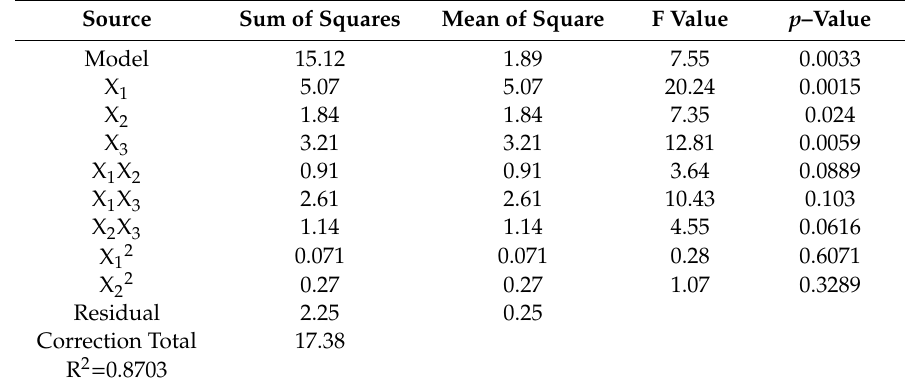
Table 5. ANOVA analysis results of Central Composite Design (CCD) for yeast and mold count in US pasteurization process (log CFU /